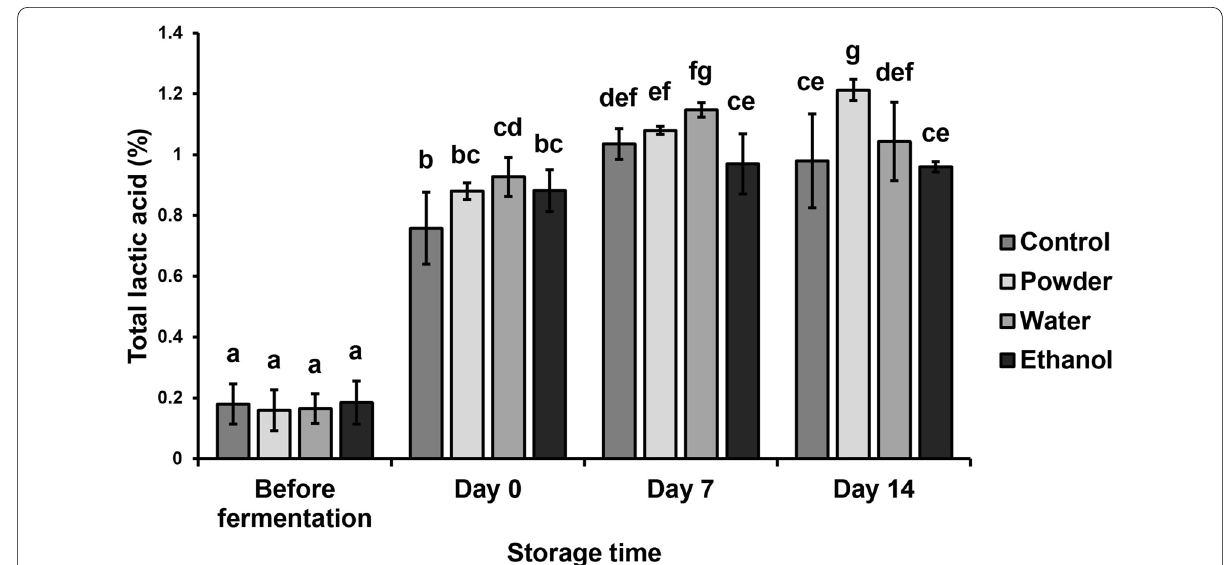
Fig. 3 Titratable acidity of yogurt samples during storage (4 °C). Bars with different letters are significantly different ( p <